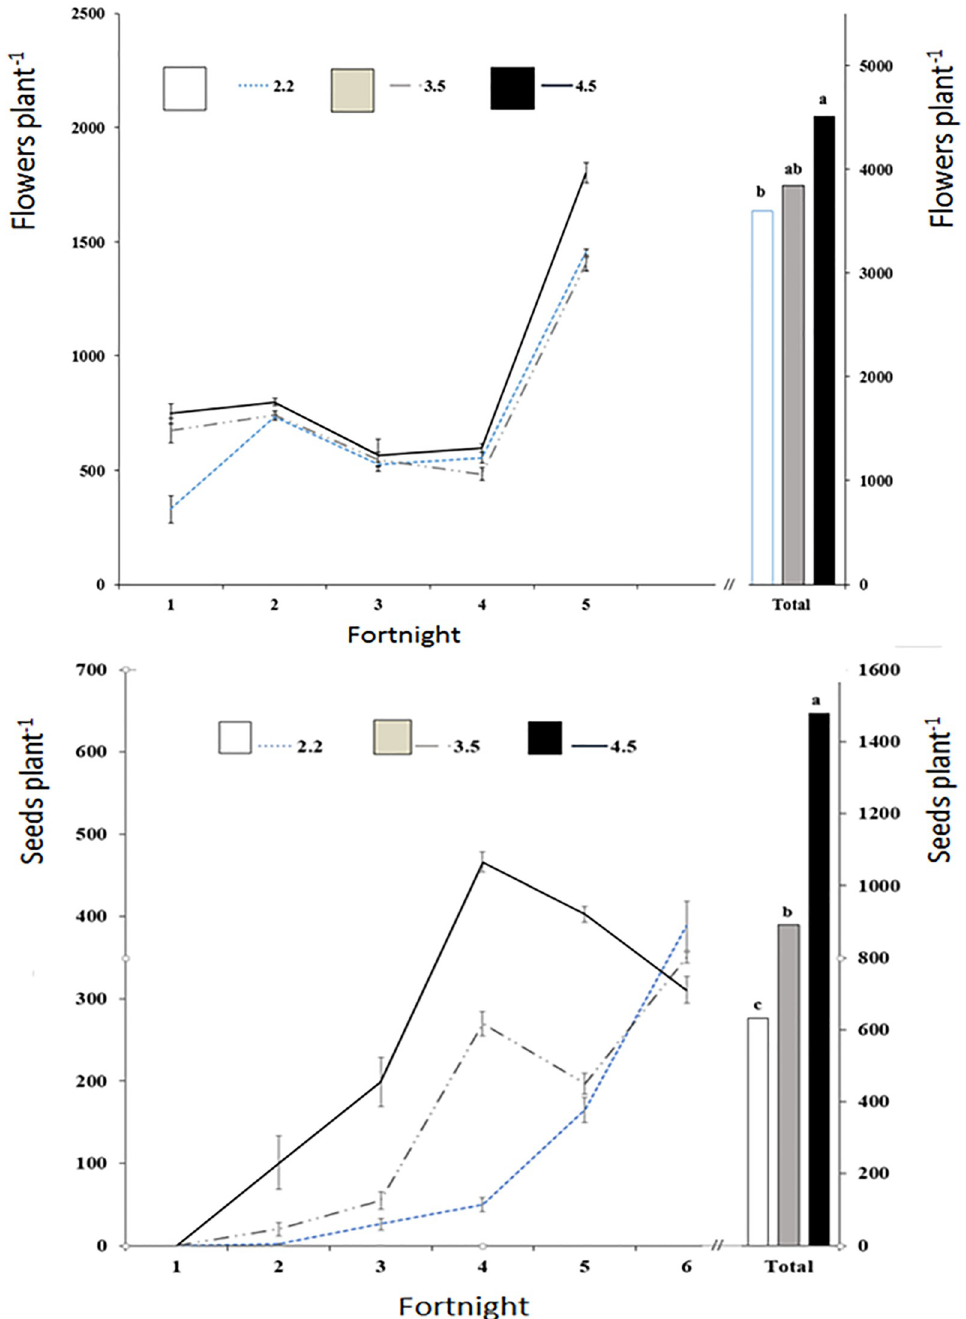
Fig 1. Flowers and seeds of borage crop versus electric conductivity (dS m -1 ). Different letters indicate significant difference at P � 0.05 according to Tukey´s test.